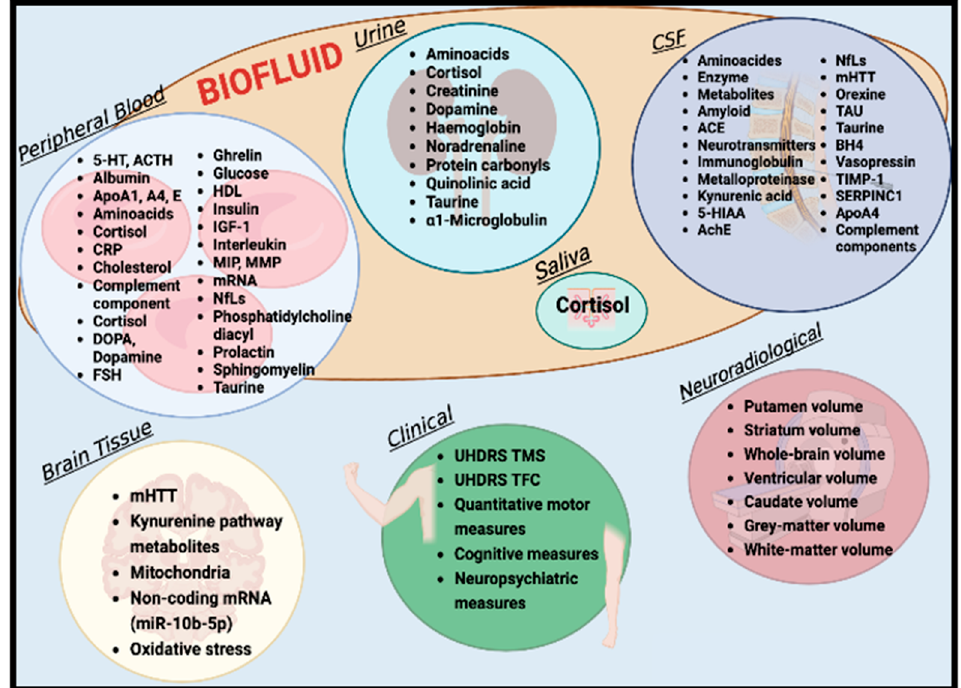
Figure 2. Biomarkers for Huntington’s disease